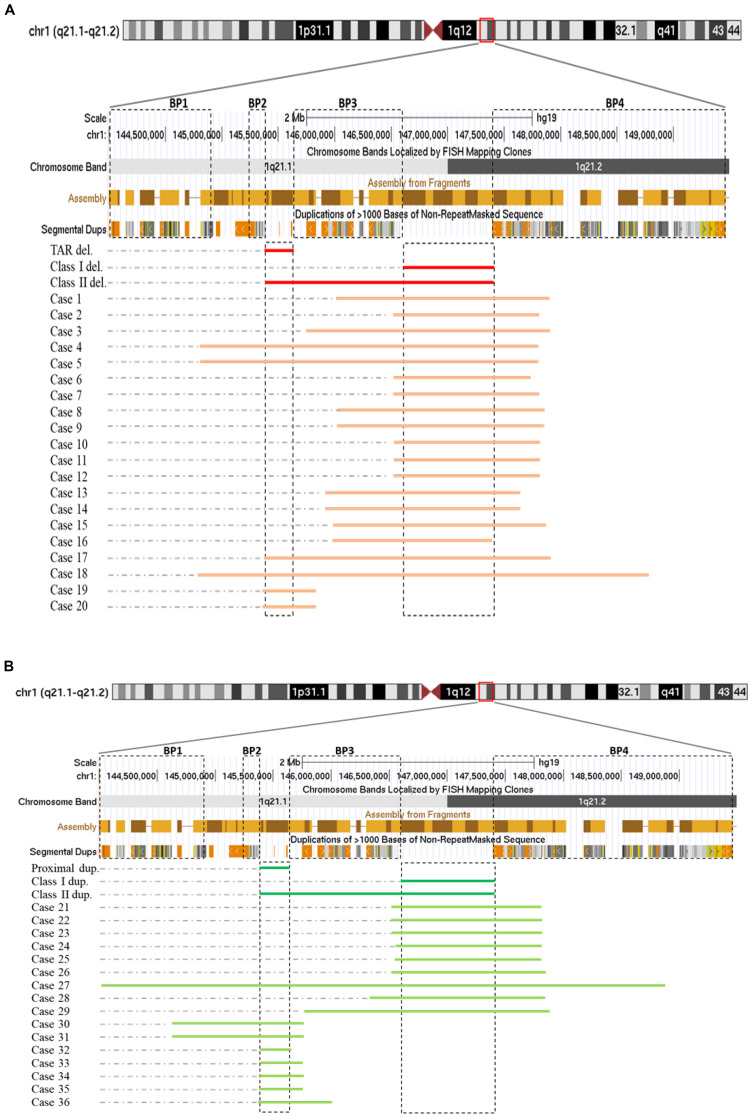
Schematic representations of deletions (A) and duplications (B) at 1q21.1 (GRCh37/hg19, 144.0–149.5 Mb). Breakpoint regions (BP1–BP4) in dotted squares were delineated according to Mefford et al. (2008). Class I, class II, and thrombocytopenia-absent radius (TAR) deletions (labeled as class I del, class II del, and TAR del) were drawn based on Brunetti-Pierri et al. (2008) with modification. In a similar way, class I, class II, and proximal 1q21.1 duplications were generated. We narrowed down the sizes of TAR deletions/proximal 1q21.1 duplications and class I deletions/duplications down to minimal sizes approximately 200 and 800 kb as being reported (Cooper et al., 2011; Albers et al., 2013).